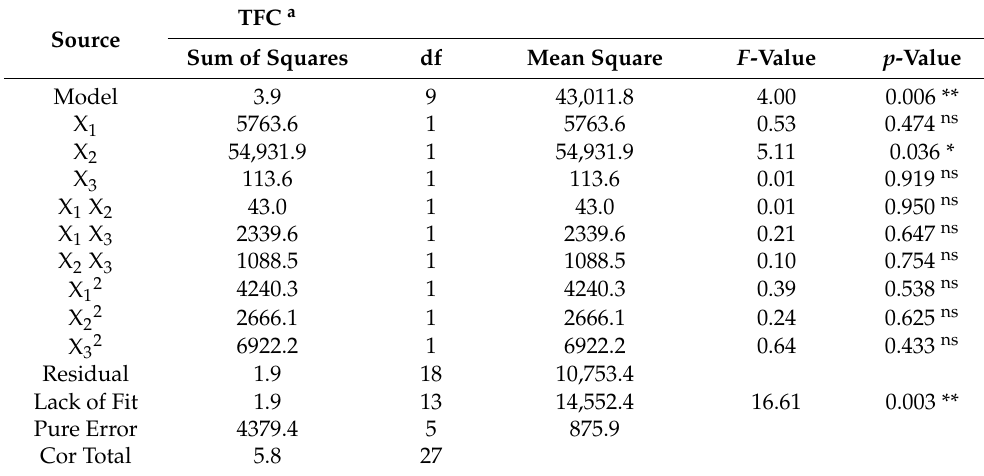
Table 4. ANOVA for response surface polynomial model of all independent